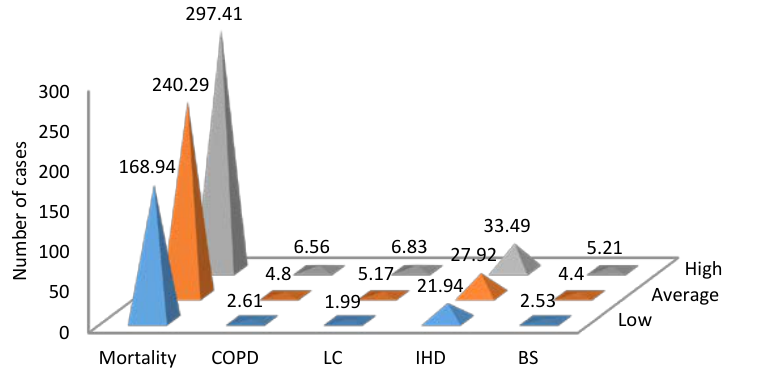
Fig. 4. Estimated attributable cases per100000 population at risk